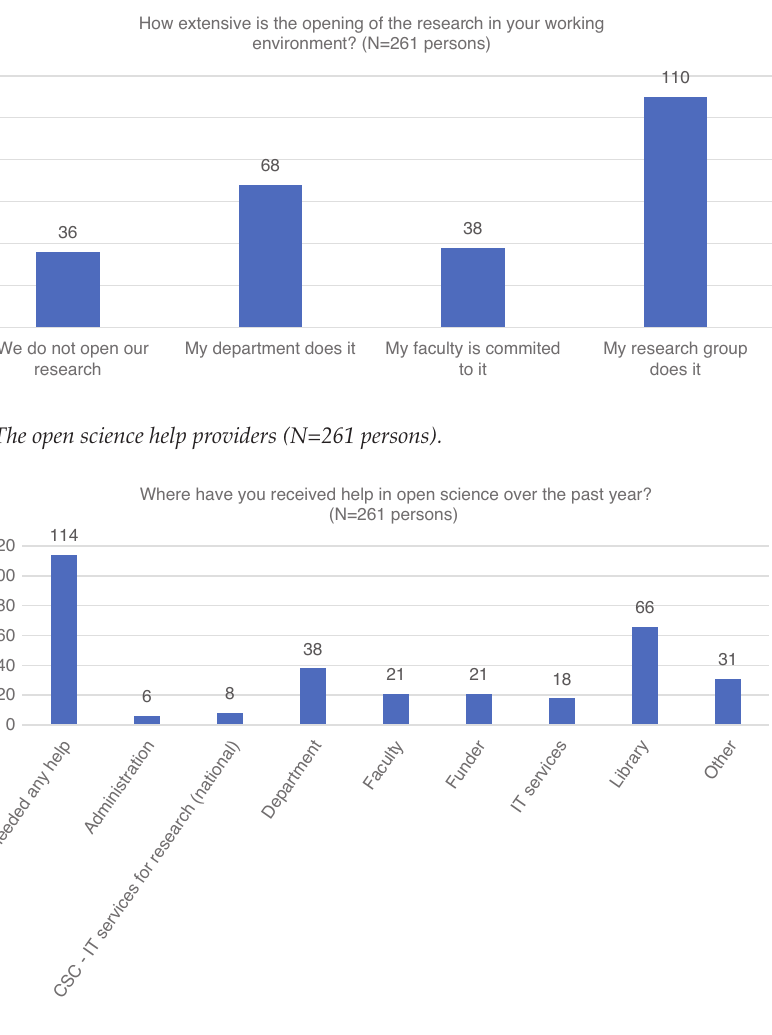
Fig. 8: The extensiveness of the opening of the research (N=261 persons).